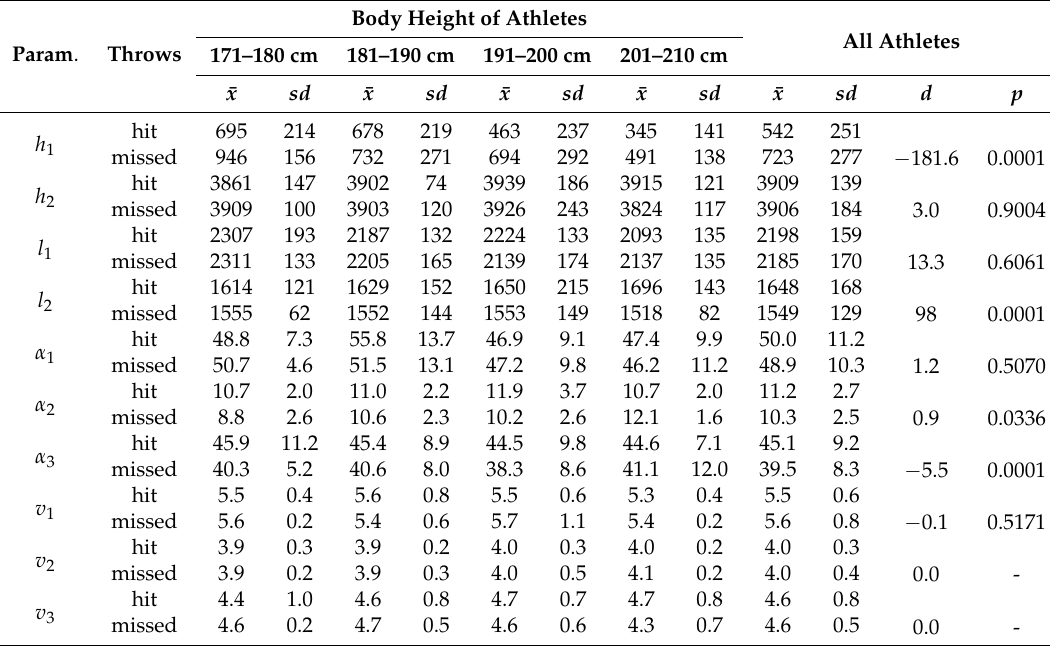
Table 2. Estimated parameters of the free throw